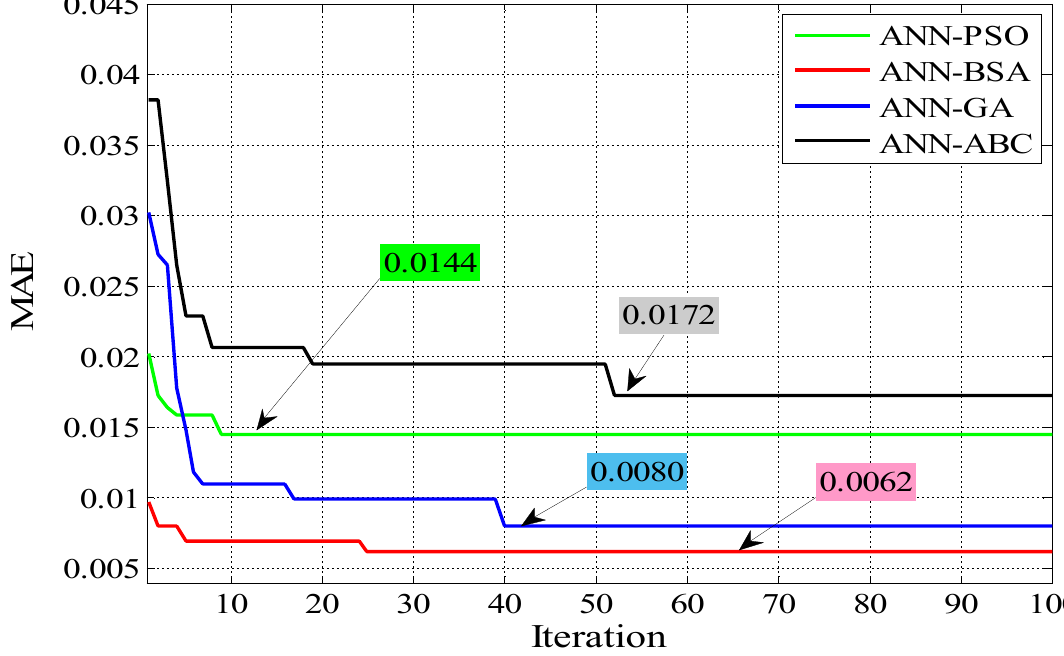
Electronics 2021 , 10 , x FOR PEER REVIEW Figure 8. ANN Architecture Based on PSO, GA, ABC, and BSA algorithms, using input and output data obtained from [208]. Table 12. Optimization algorithms data and limitations.